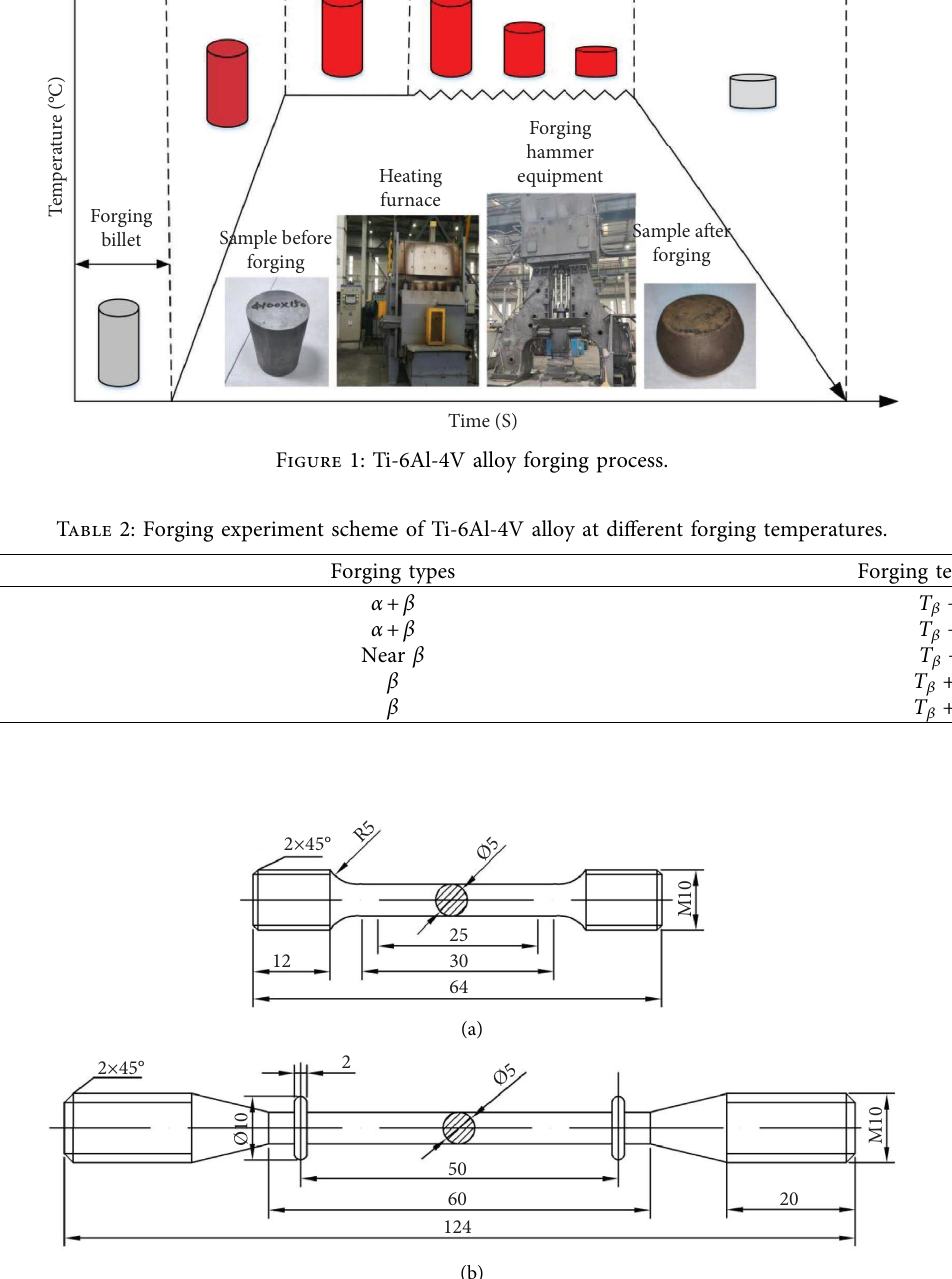
Figure 2: Geometrical sizes of the sample of Ti-6Al-4V alloy (unit: mm): (a) high-temperature tensile sample; (b) creep